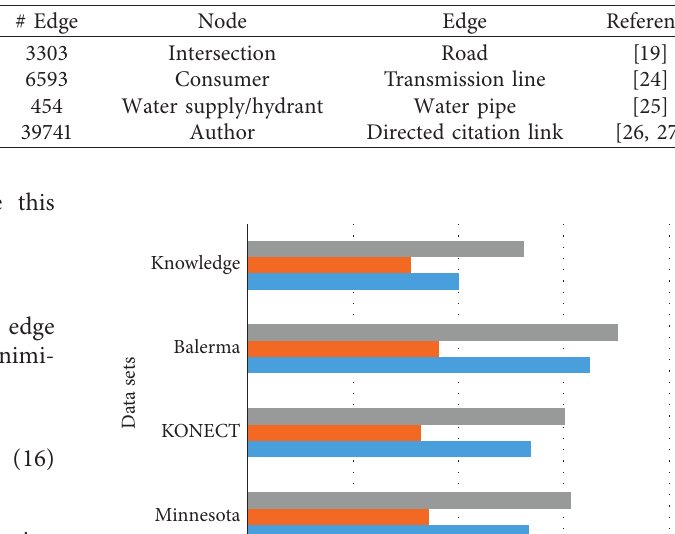
Table 1: Dataset summary.